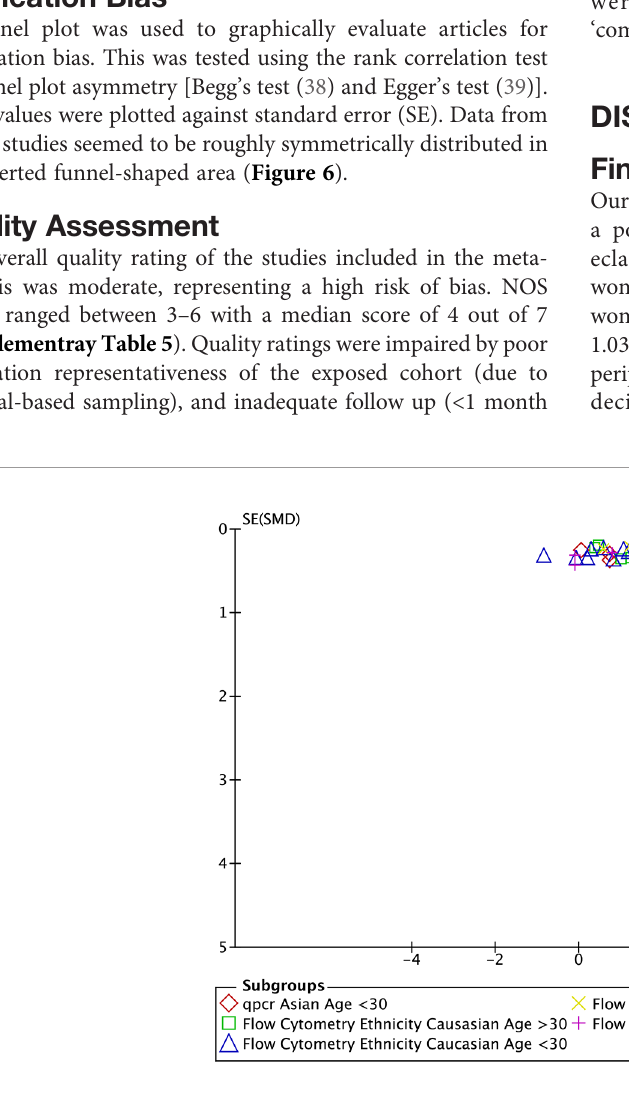
FIGURE 6 | Funnel plot for studies looking at the number of Tregs in the maternal blood included in the subgroup meta-analysis (n=30). SE, standard error; SMD, standardised mean difference.